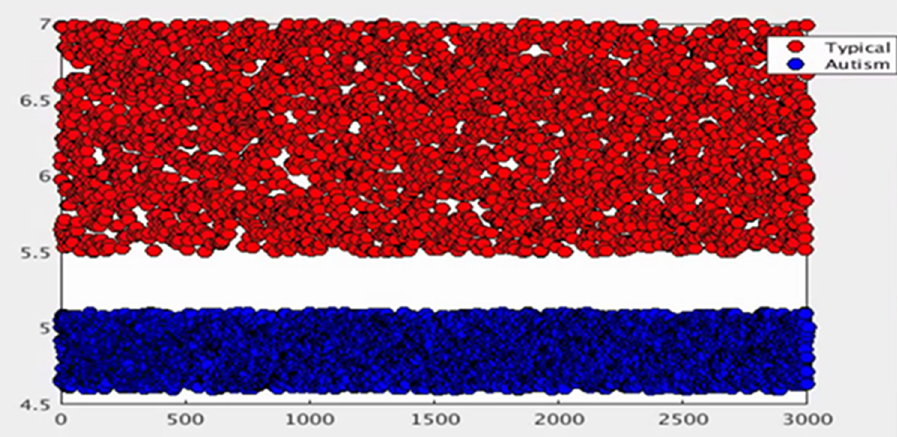
Figure 5. Data distribution after preprocessing